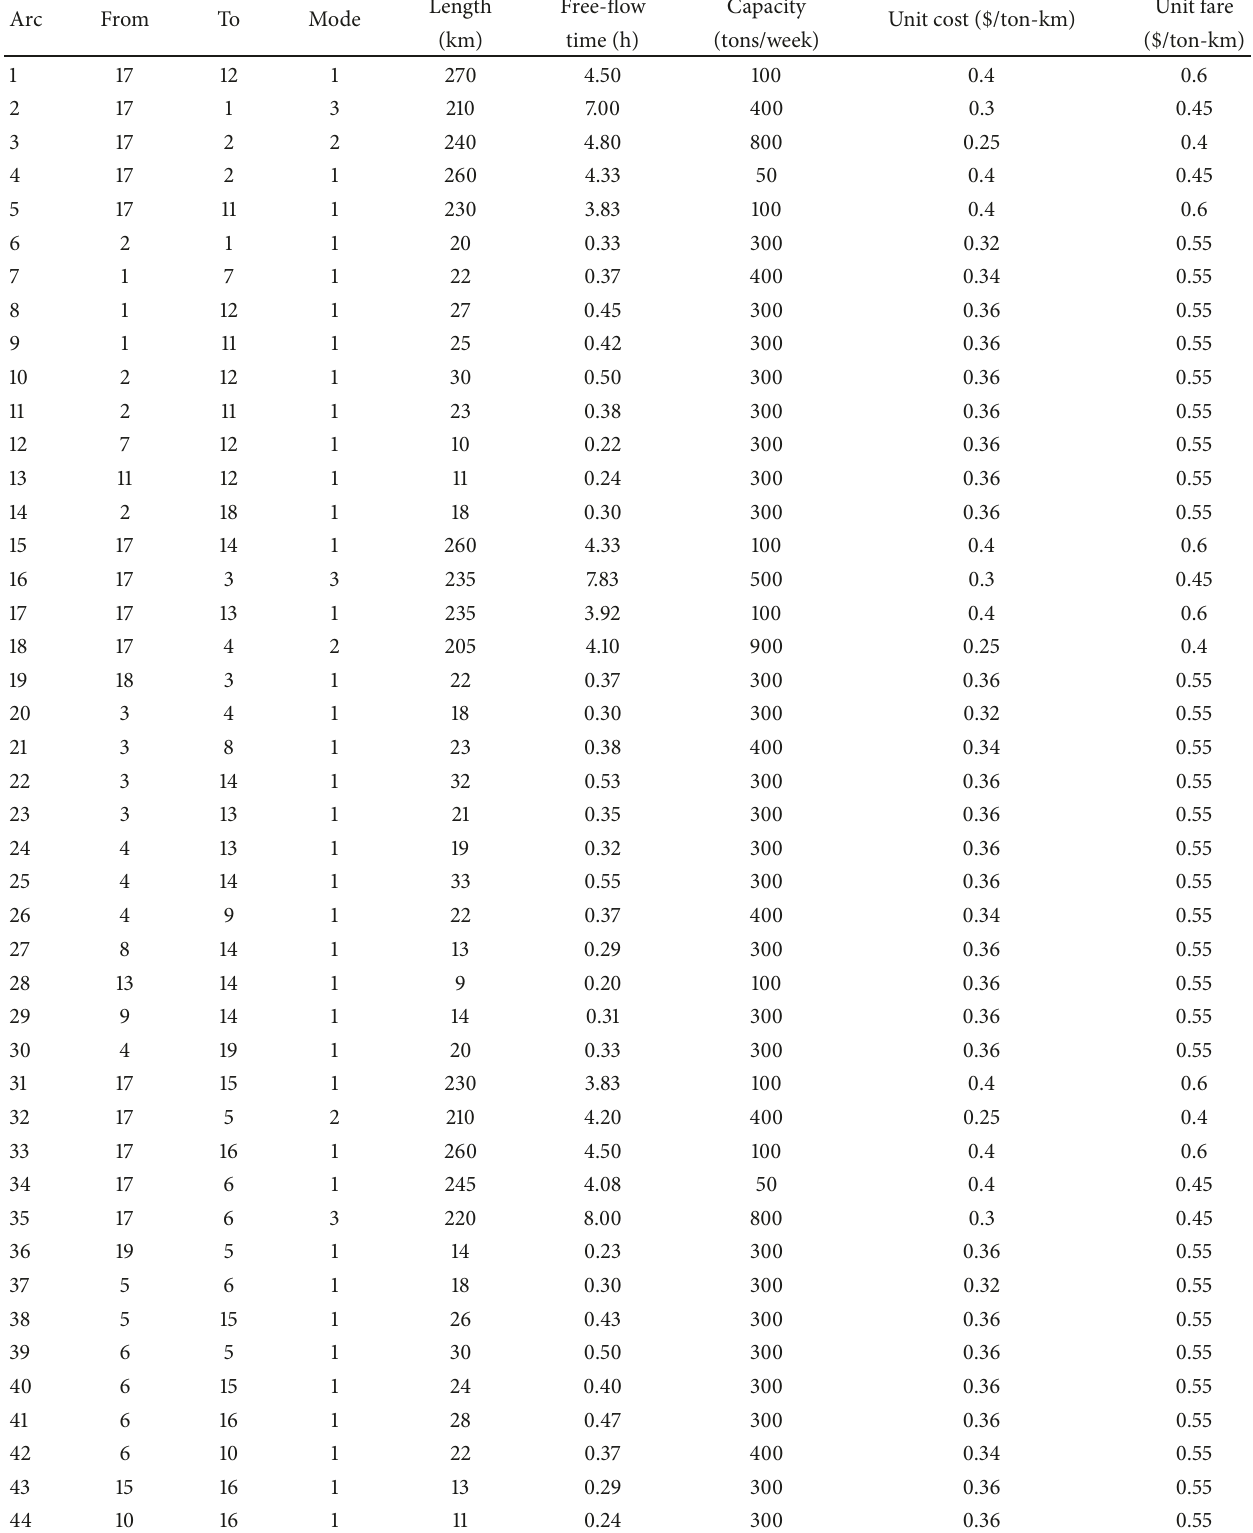
Table 8: Basic data of each arc in the